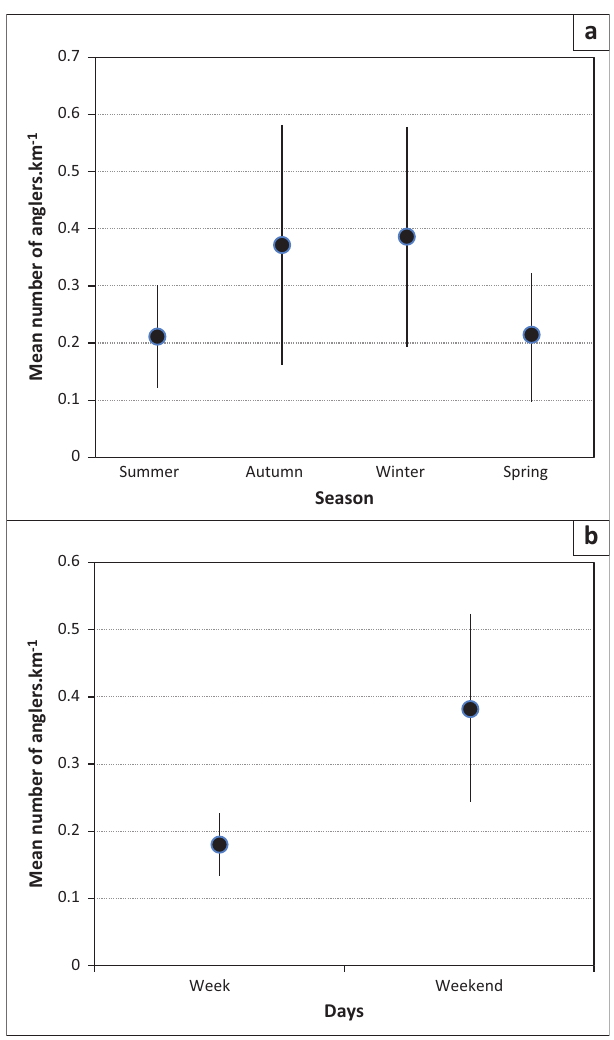
FIGURE 5: Mean shore angling effort (anglers.km -1 ) (a) seasonally and (b) during week and weekend days along the South African Garden Route coast